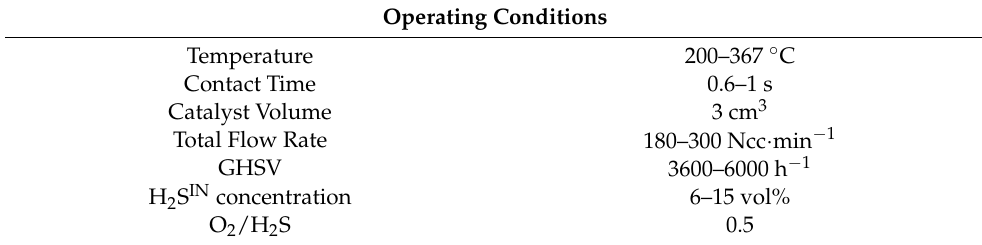
Table 6. Operating